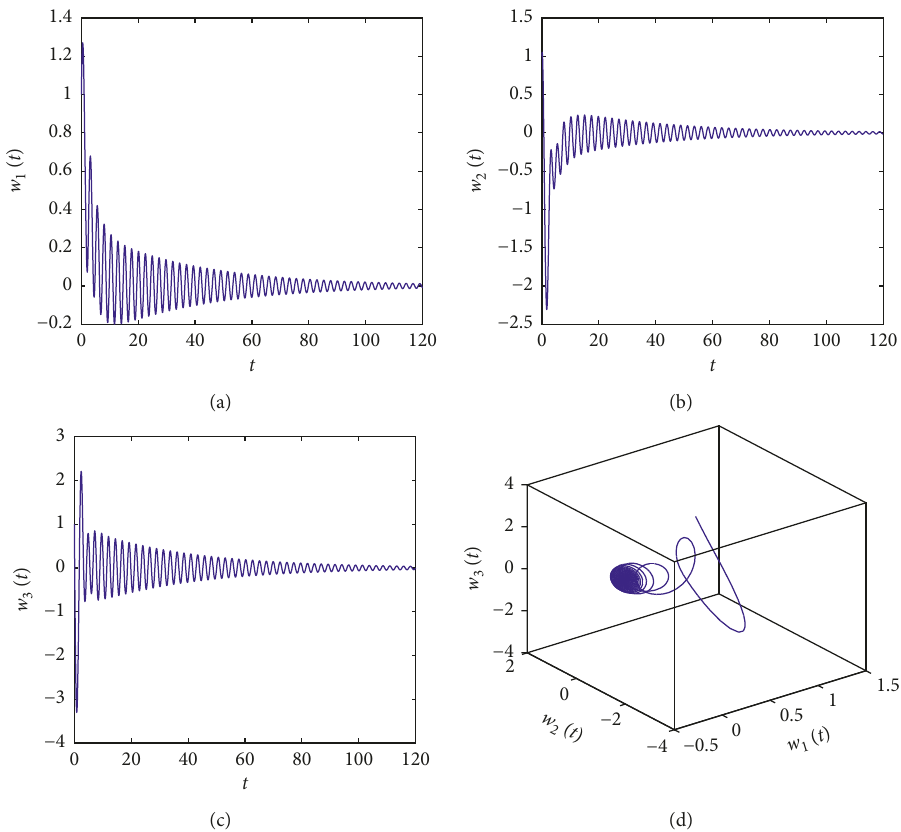
Figure 3: Computer simulations of model (69) when 9